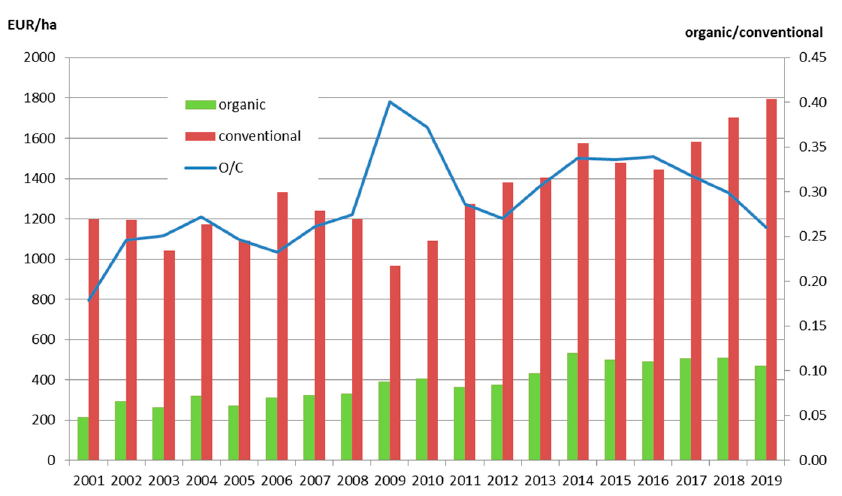
Figure 2. Agriculture production per hectare in ANC (Areas with Natural Constraints). (Source: [38], authors’ elaboration).